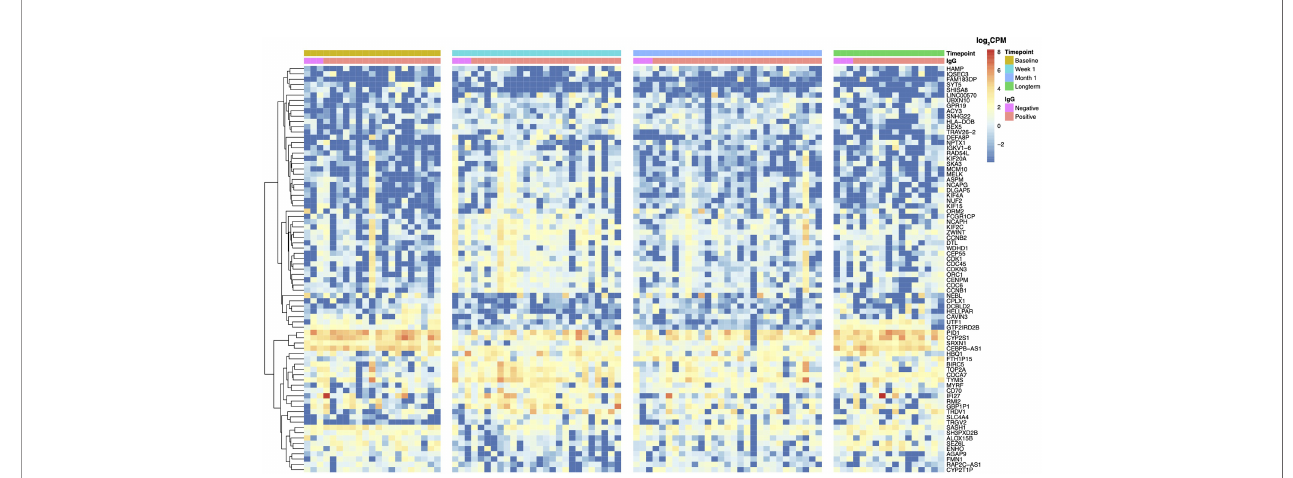
FIGURE 3 | Heatmap of clustered DEGs across all timepoints for patients with CMV viremia. DEGs with |logFC| ≥ 2 at baseline versus week 1 post-viremia are shown. Red indicates increased expression, while blue indicates decreased expression compared with baseline. CMV IgG status of transplant recipient is indicated, with high-risk patients (D+/R − ) shown in pink and intermediate-risk (R+) in orange. Timepoints are indicated as baseline (brown), week 1 (turquoise), month 1 (blue), or long-term (green) in bars at the top of the fi gure. Each column represents an independent patient